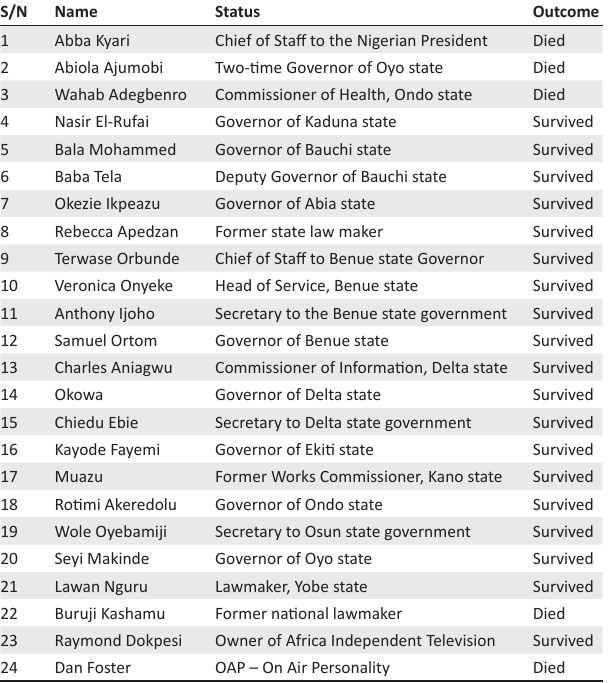
TABLE 1: Some prominent names of those who have contracted COVID-19 in